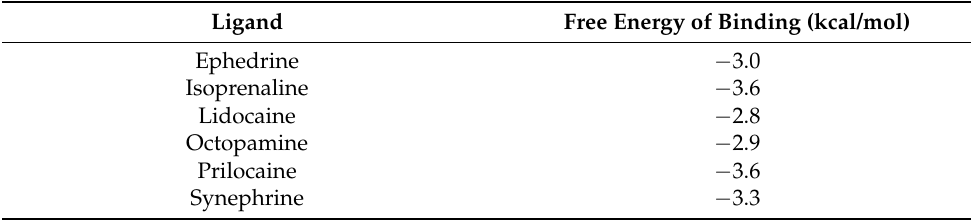
Table 5. Free energies of binding of different positive controls onto